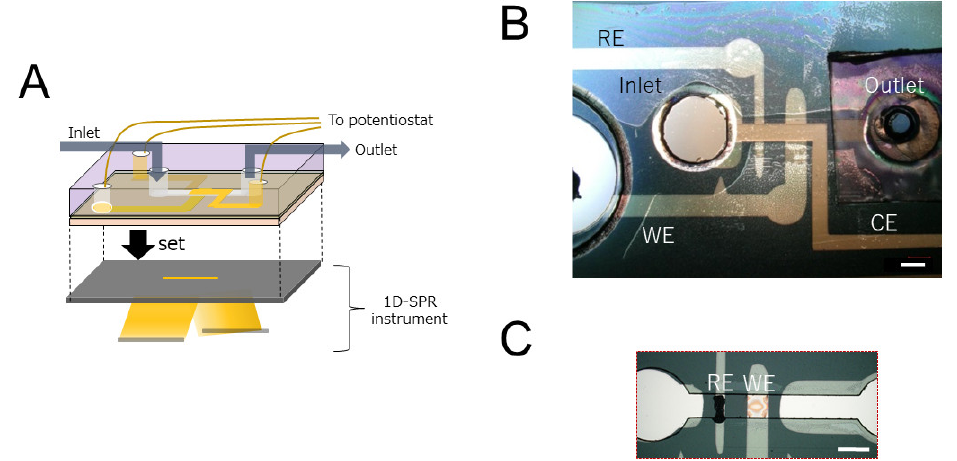
Figure 2. EC-SPR measurement chip layout. ( A ) Chip layout of EC-SPR measurement. ( B ) Photograph of electrodes after the glass substrate and acrylic substrate were bonded. RE: Reference electrode, WE: Working electrode, CE: Counter electrode. ( C ) Photograph of reference electrode and working electrode on glass substrate. Each scale bars are 1 mm.